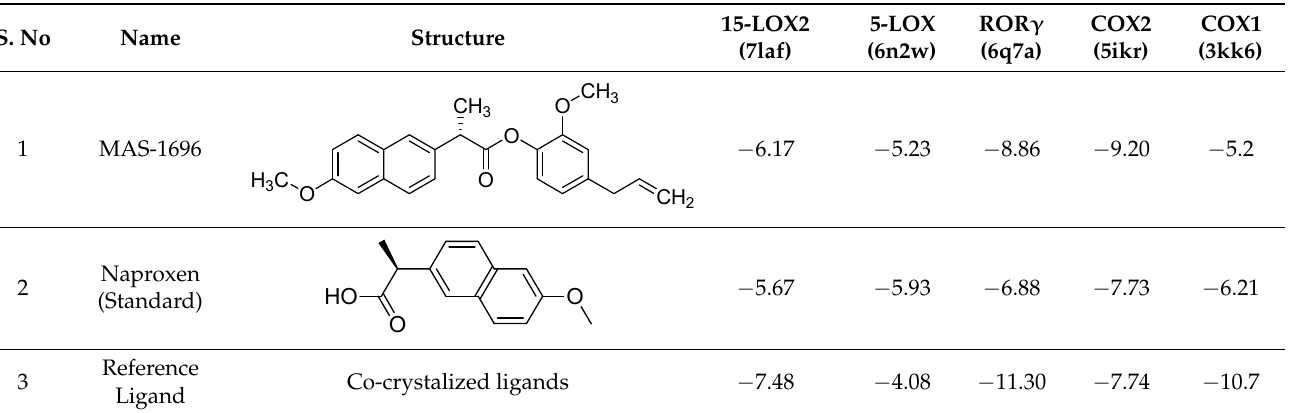
Table 1. Docking score of designed conjugate ligand and standard drug naproxen against various inflammatory drug targets.